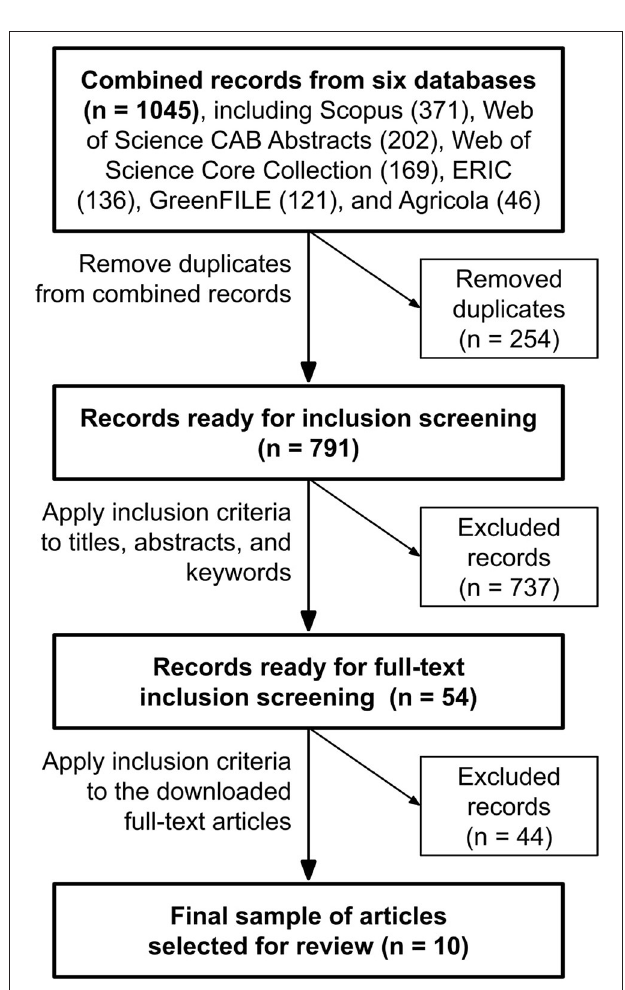
FIGURE 1 | Search results